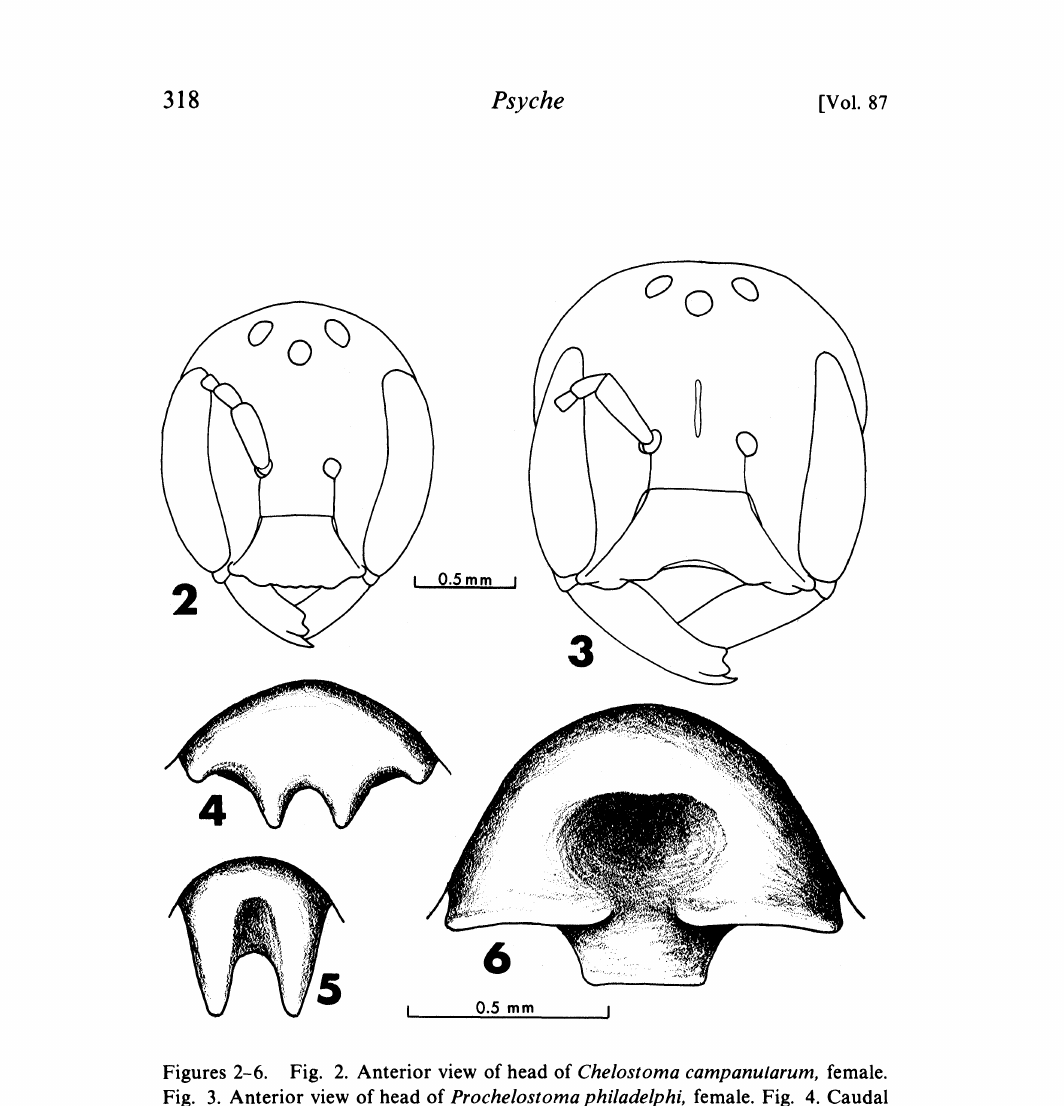
Fig. 3. Anterior view of head of Prochelostoma philadelphL female. Fig. 4. Caudal view of metasomal tergum VII of P. philadelphL male. Fig. 5. Caudal view of metasomal tergum VII of C. campanularum, male. Fig. 6. Caudal view of metasomal tergum VII of Chelostoma fuliginosum,